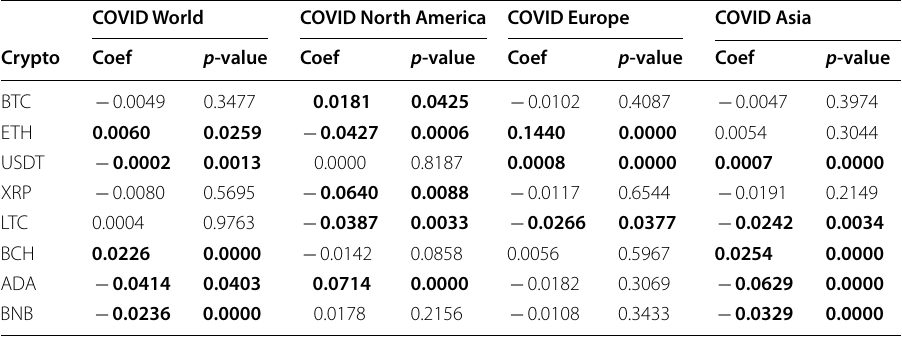
Table 5 CCs price return strength models are explained by the absolute value of the variation in effective reproductive